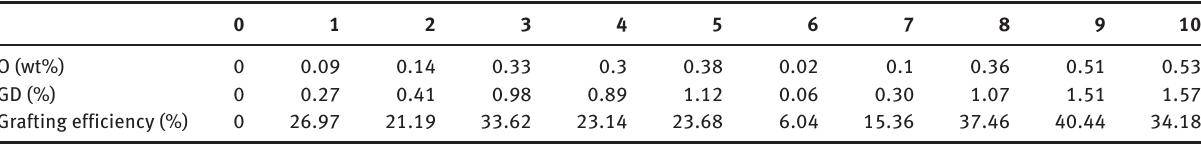
Table 1 Elemental analysis results of ABS and